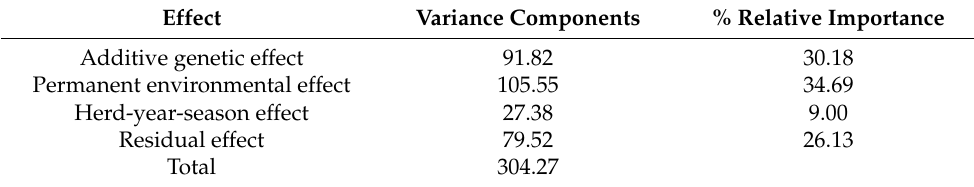
Table 2. Variance components and parameter estimates for Reproductive